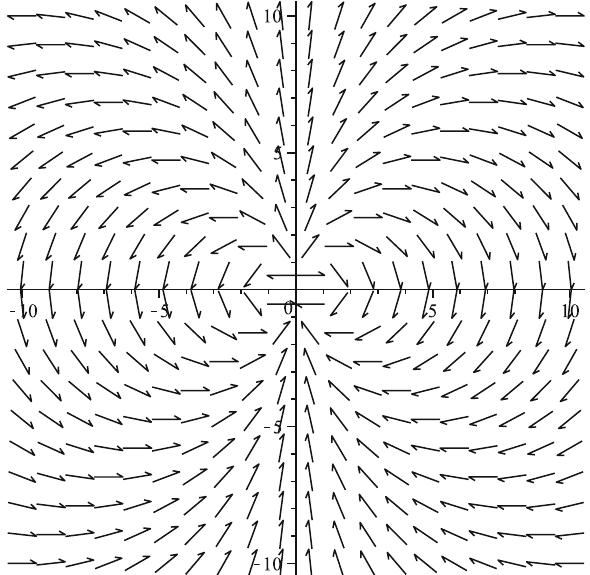
Fig. 3 Plot for the normalized force lines obtained from (29) with V = V x ˆ x and a centered at the origin